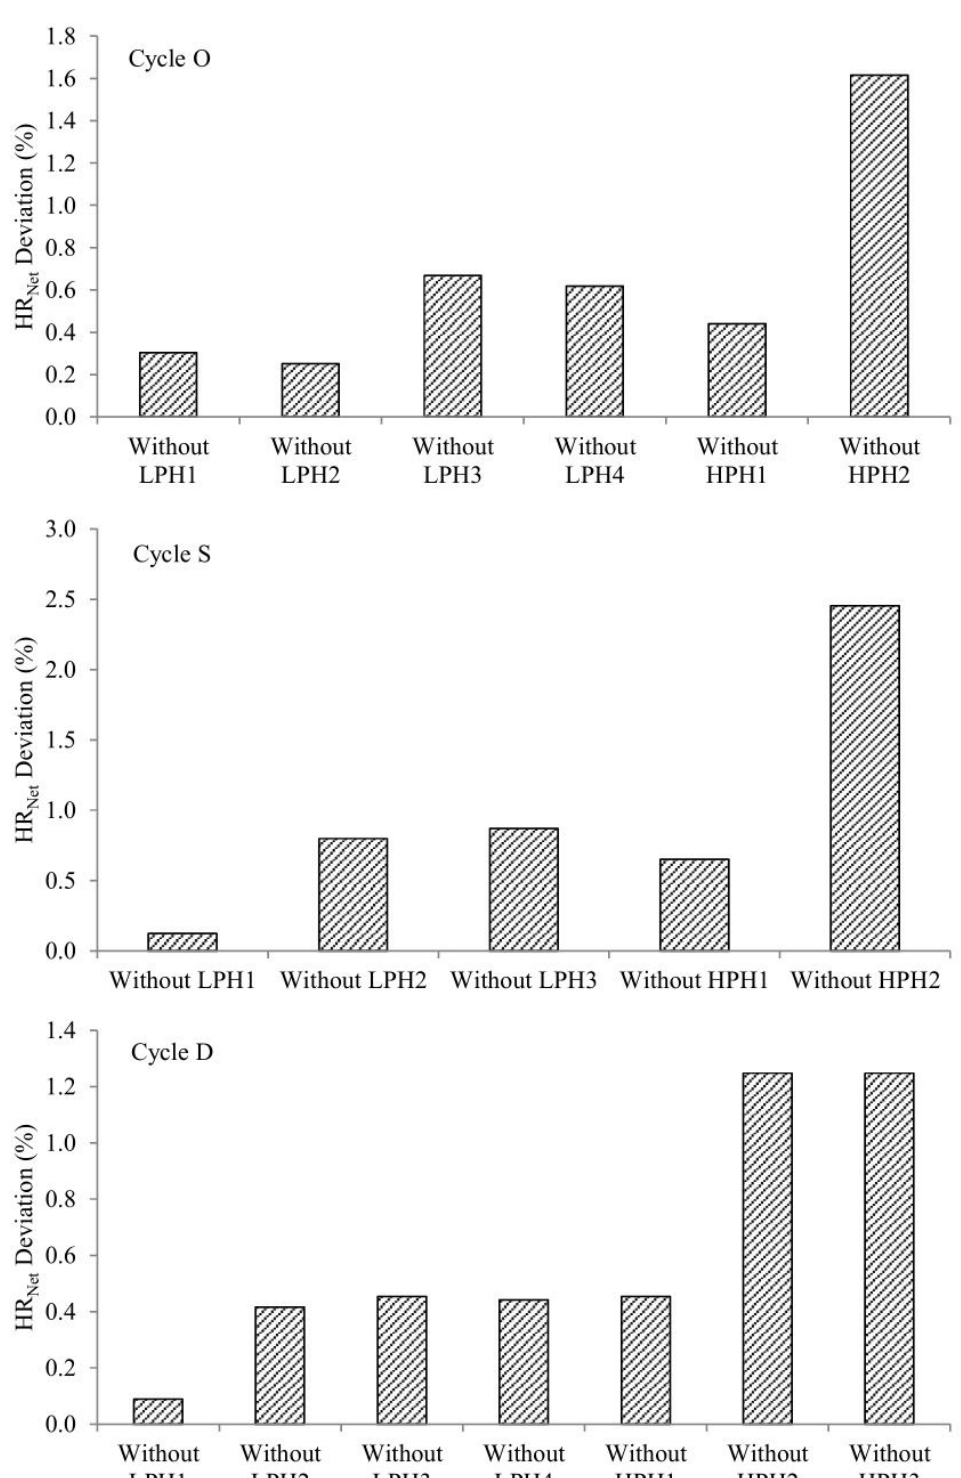
Figure 12. Influence of having one feedwater heater out of service on HR Net (HR Net ; net heat rate) for cycles O, S, and D for heating surfaces (LPH1 / 2 / 3 / 4: low pressure feedwater heater 1 / 2 / 3 / 4, HPH1 / 2 / 3: high-pressure feedwater heater 1 / 2 / 3); Reprint with permission [89]; 2019, John Wiley and Sons. An non-conventional load change from 40% to 100% load was simulated in [90]. A coal-fired power plant detailed model was developed with Modelica ® Modelon ThermoPower library. Each component of the plant and the whole plant was validated against operational data. One soft start-